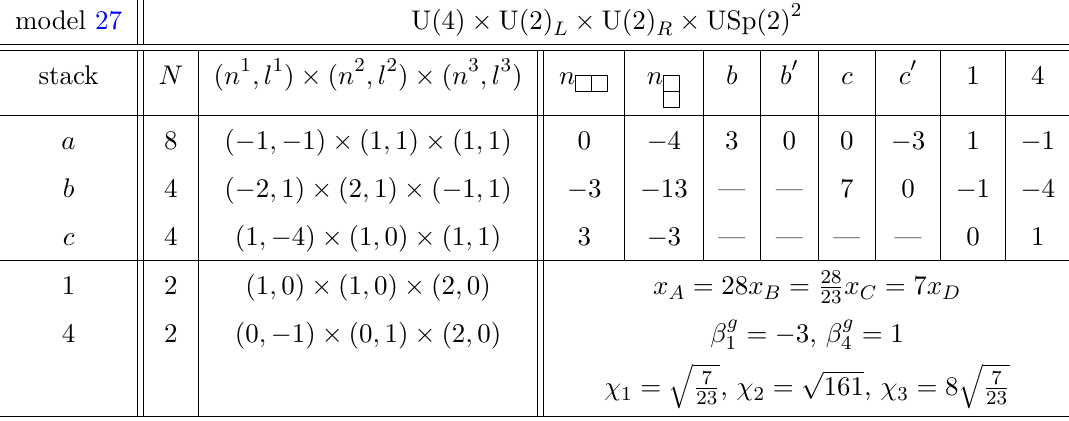
Table 27 . D6-brane configurations and intersection numbers of Model 27, and its MSSM gauge